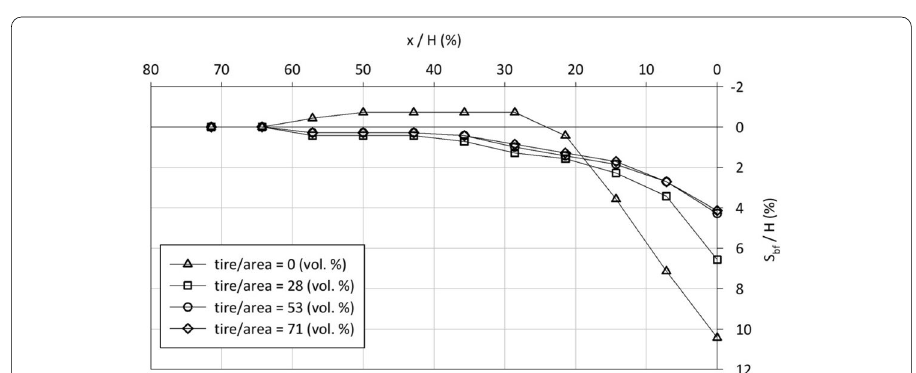
Fig. 18 Settlements near the abutment after 120